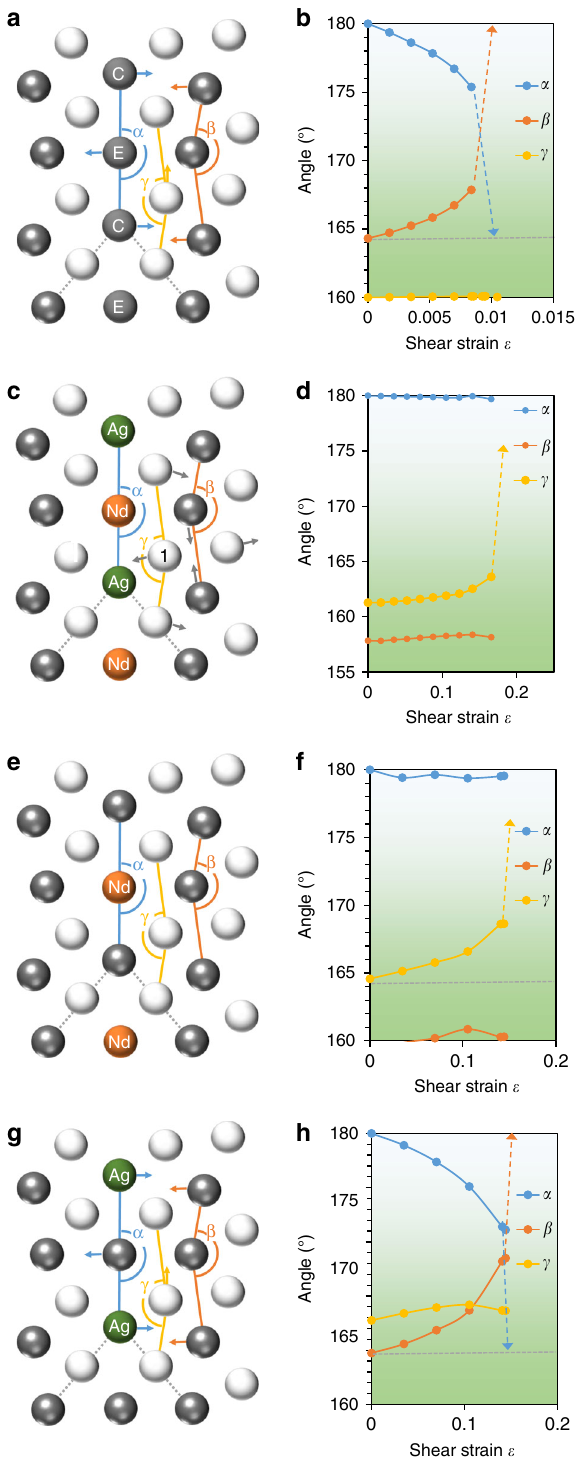
Fig. 4 In fl uence of segregated solute(s) on 10 (cid:1) 12 ð Þ twin boundary migration mechanism. a Schematic of a twin boundary containing Mg at both compression (C) and expansion sites (E), and b variation of angles α , β and γ with applied shear strain. c Twin boundary containing Ag at the C site and Nd at the E site, and d change in angles α , β and γ with shear strain. e Twin boundary containing Nd at the E site, and f variation of angles α , β and γ with shear strain. g Twin boundary containing Ag at the C site, and h change in angles α , β and γ with shear strain